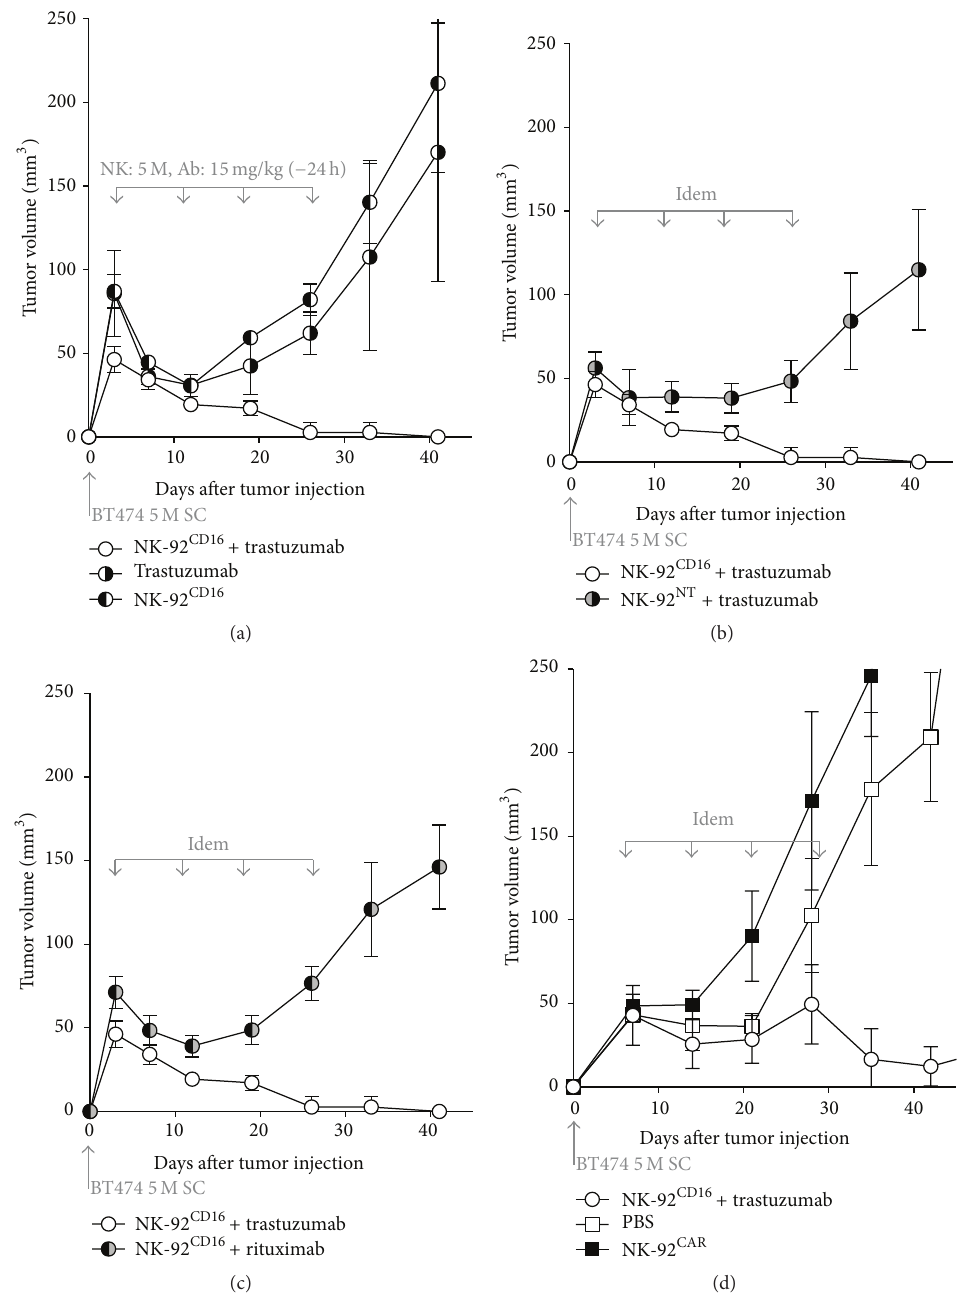
Figure 4: The NK- 92 CD 16 in the presence of trastuzumab but not NK- 92 CAR induces regression of the HER2 positive BT474 tumor engrafted in NSG mice. Results presented in (a), (b), and (c) are from the same series of experiments but are presented separately for readability: the group of mice treated with NK- 92 CD 16 + trastuzumab is thus the same for (a), (b), (c), and (d). Six-week-old female NSG mice were injected subcutaneously in the left side with 5 × 10 6 BT474 cells. When tumors reached a minimal volume of 50 mm 3 (within 5–7 days), mice were individually identified and randomly assigned to the control or treated groups (5 to 15 mice per group) and the indicated treatments were